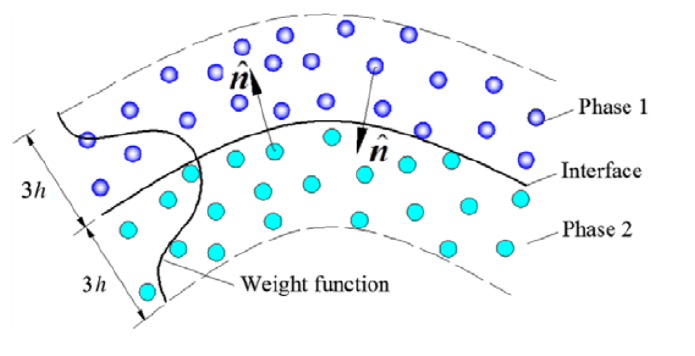
Figure 3. Sketch of the Continuum Surface Force (CSF) model in SPH framework